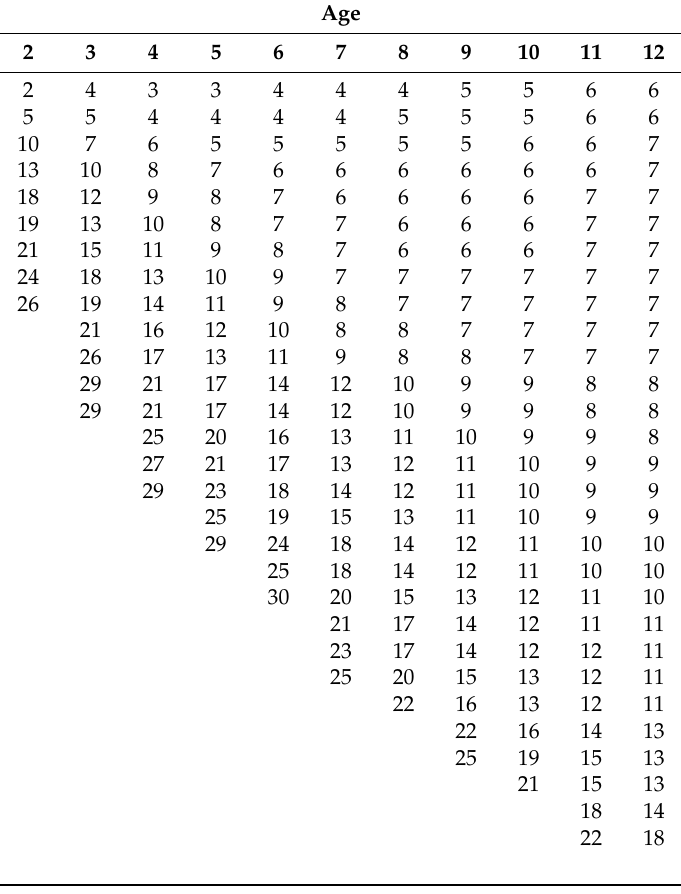
Table 3. Sociability subscale score norms as a function of the initial score and age from Figure 4.